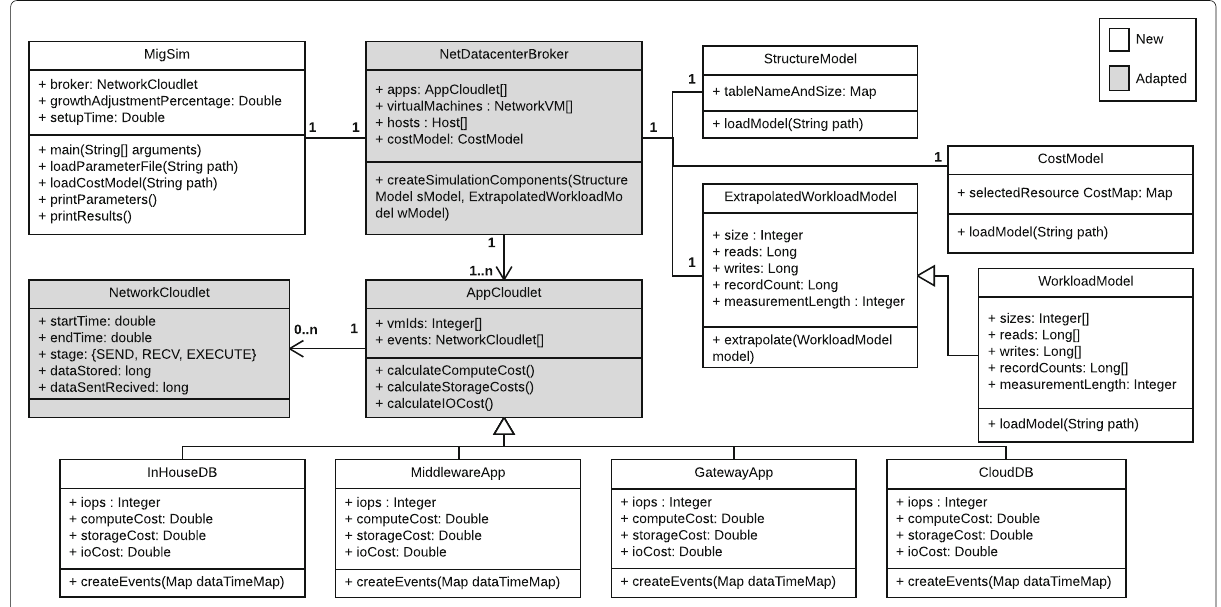
Fig. 3 UML2 class diagram showing the new major new components in MigSim, as well as those adapted from CloudSim